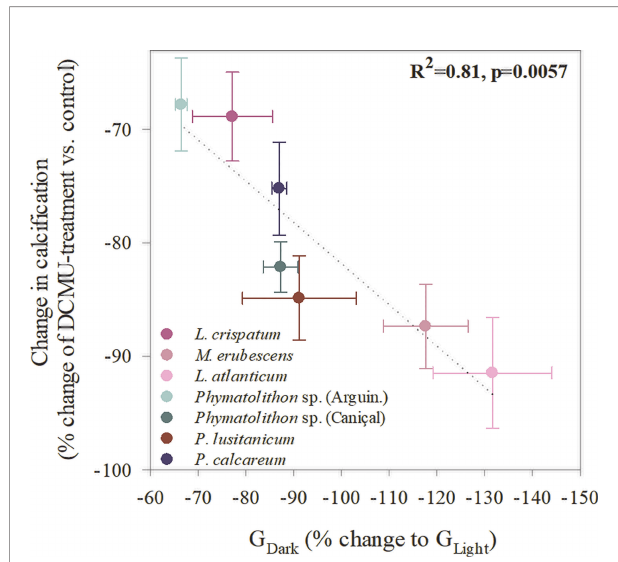
FIGURE 6 | Relationship between rhodolith calci fi cation in darkness and after photosynthesis inhibition with DCMU in light, expressed as changes in relation to light calci fi cation and to control values before inhibitor treatment, respectively. Data points represent mean ± SE